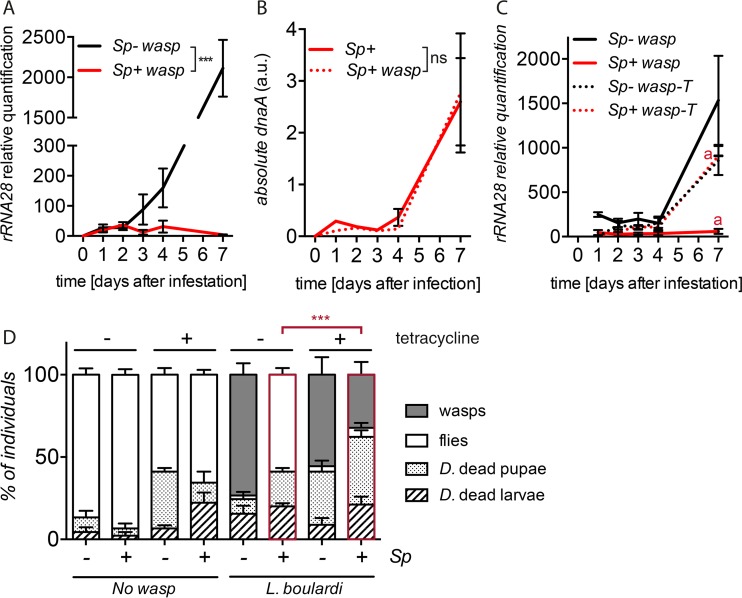
Spiroplasma inhibits wasp growth at the pupal stage. (A and C) Quantification of wasp growth was performed by monitoring the amount of wasp 28S rRNA relative to D. melanogaster RpL32 RNA in D. melanogaster larvae/pupae harboring (Sp+) or not harboring (Sp−) S. poulsonii. ***, P < 0.001 for comparison of wasp growth in presence or absence of S. poulsonii (A); ***, P < 0.001; t = 24.22; df = 4, for comparison of wasp growth with or without tetracycline treatment at 7 days using unpaired Student t test (C). (B) S. poulsonii absolute titers monitored by qPCR of the S. poulsonii dnaA gene. Wasp infestation has no effect on S. poulsonii growth. Not significant [ns], P = 0.2867. (A and B) Statistical significance of the data was calculated using two-way analysis of variance (ANOVA); see details in Table S1 in the supplemental material. (D) Quantification of D. melanogaster (D.) dead larvae and pupae, fly adults, and wasp adults on medium complemented or not, 1.5 days postinfestation, with the bacteriostatic antibiotic tetracycline. ***, P < 2.2 × 10−16; chi-square = 102.61; df = 3, using Pearson’s chi-squared test. Results are the percentages of a minimum of 270 Drosophila larvae. (A to D) Results are means ± SEM from three independent experiments.